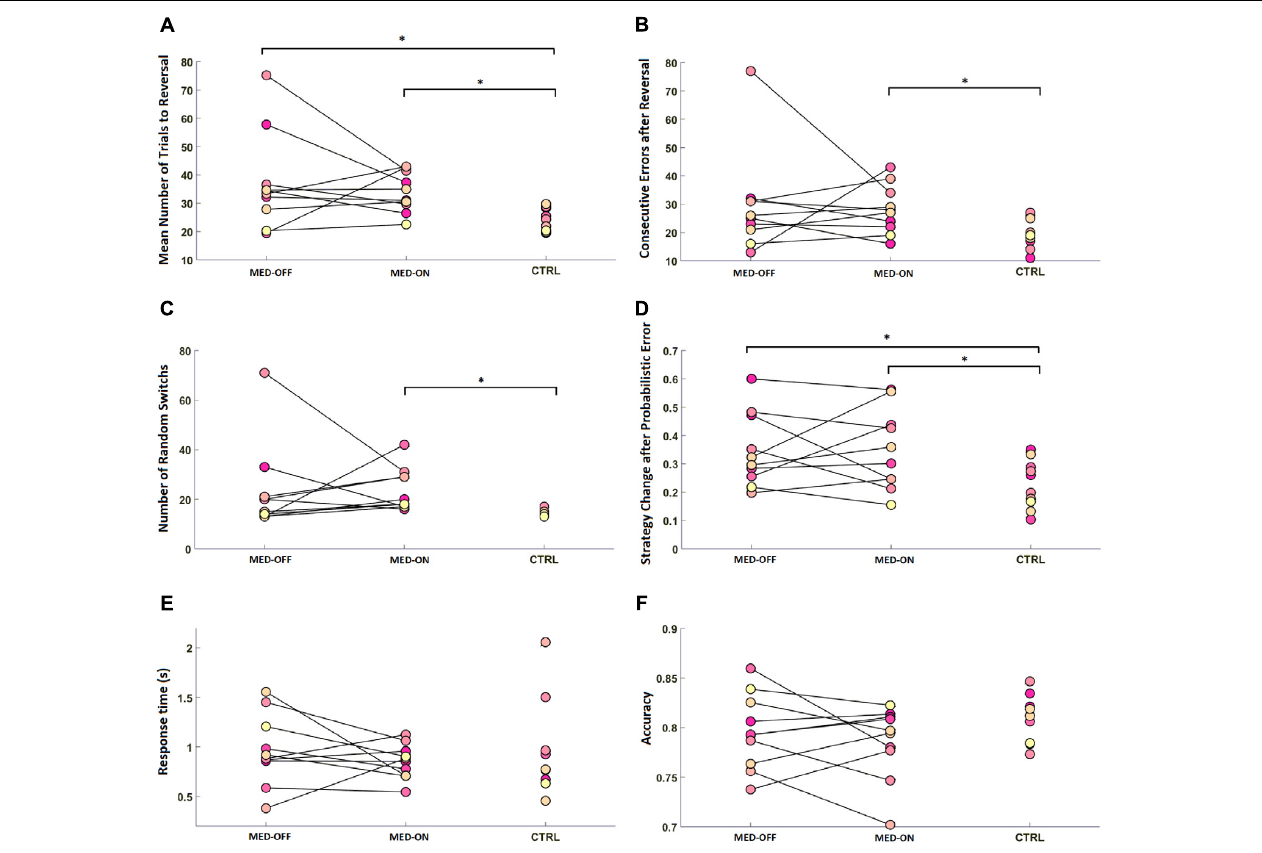
FIGURE 2 | Reversal learning (RL) results for each subject across conditions [MED-OFF, MED-ON, and Controls (CTRL)]: (A) mean number of trials to reach reversal, (B) number of consecutive errors after reversal, (C) number of random switches, reflecting a change in decision regardless of positive feedback and prior realization of a reversal pattern, (D) strategy change after probabilistic error, reflecting changes in decision due to negative feedback regardless of prior realization of a reversal pattern, (E) response time, (F) accuracy. ∗ means statistically significant